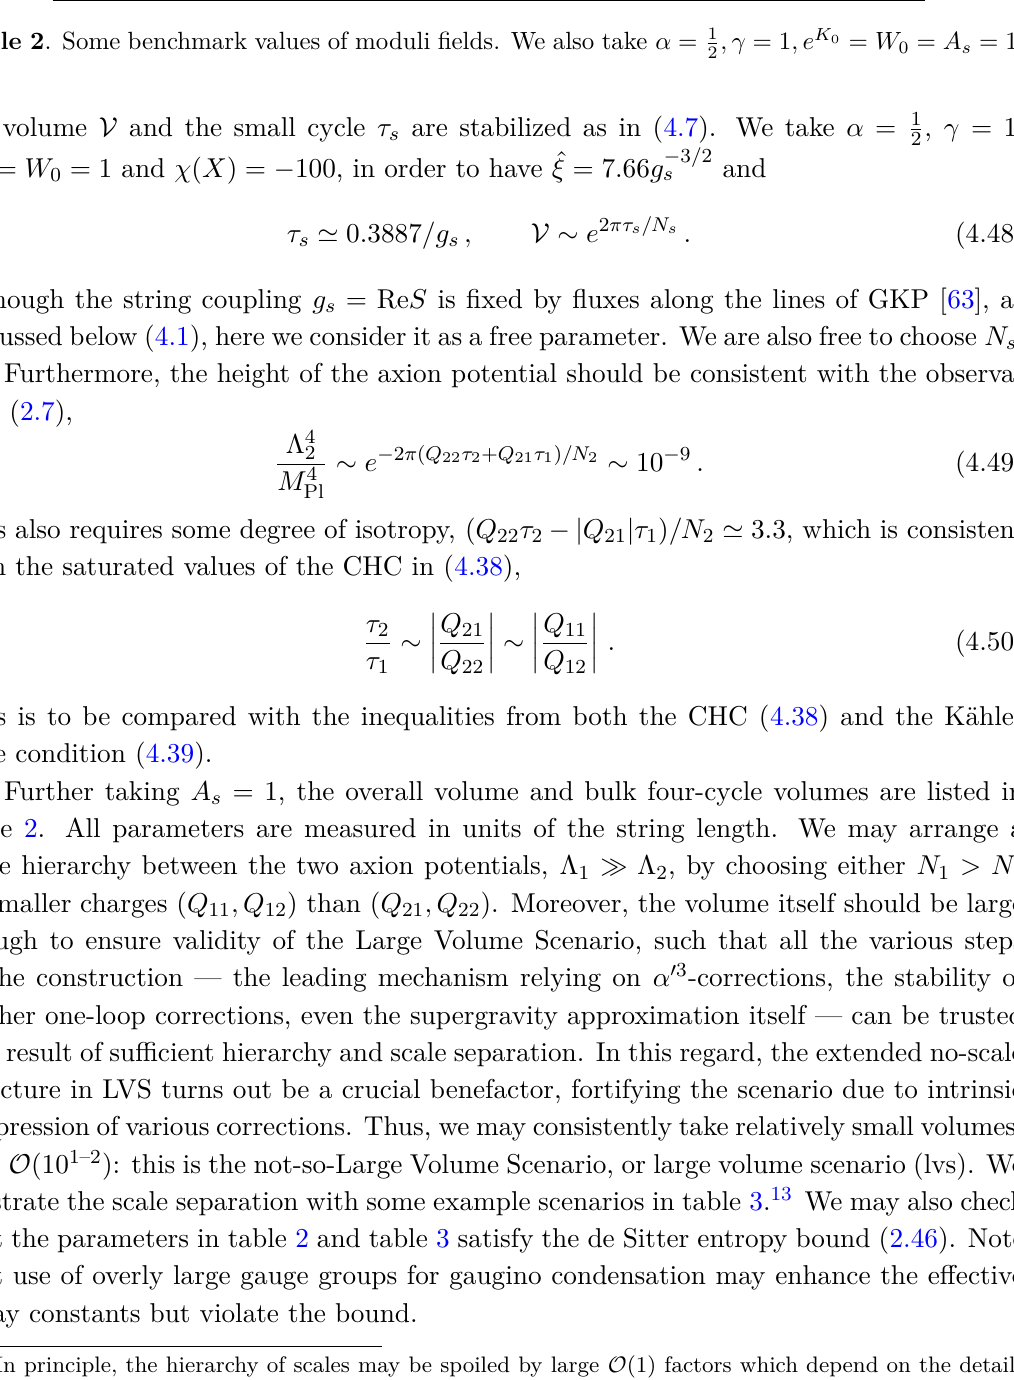
Table 2 . Some benchmark values of moduli fields. We also take α = 1